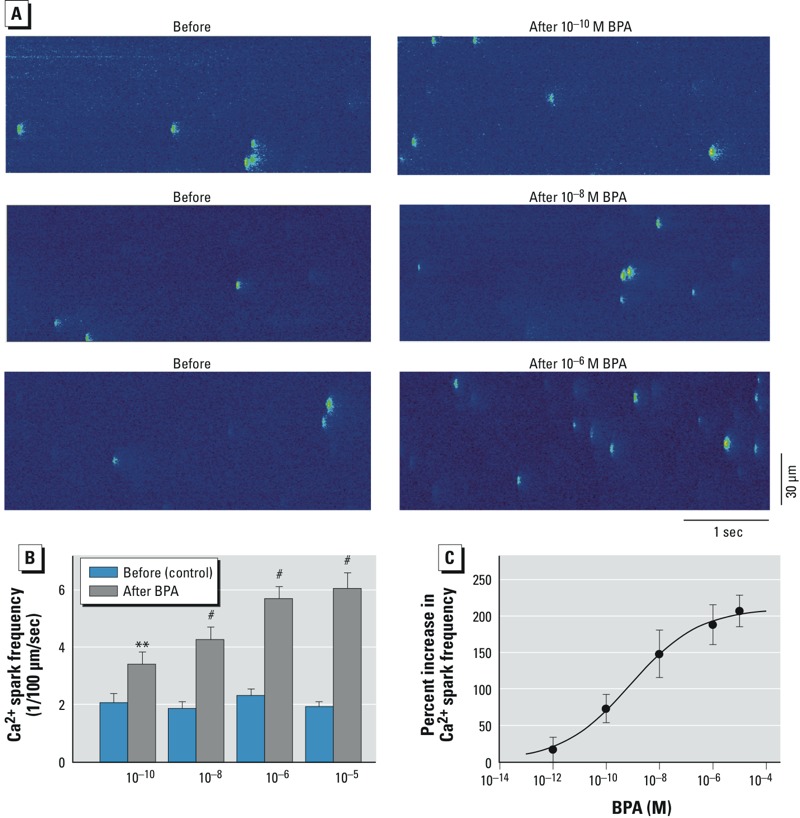
Effect of BPA on SR Ca2+ release/leak in female rat ventricular myocytes shows a monotonic dose response. (A) Ca2+ sparks recorded from three representative myocytes before and after BPA exposure (1–2 min); fluorescent spots indicate local elevations of intracellular Ca2+ levels as a result of spontaneous release of Ca2+ from the SR (i.e., Ca2+ sparks). (B) Mean (± SE) spark frequency in myocytes before and after BPA exposure (n = 8, 7, 17, and 11 myocytes for 10–10, 10–8, 10–6, and 10–5 M BPA, respectively. (C) Dose–response curve of BPA’s effect on Ca2+ spark frequency. Data are fitted with the Hill equation: Percent increase = maximum increase/{1 + (EC50/[BPA])Hill coefficient}, where maximum increase = 209.7%, EC50 = 0.814 nM, and Hill coefficient = 0.34.
**p < 0.01, and #p < 0.001, compared with control by paired t-test.